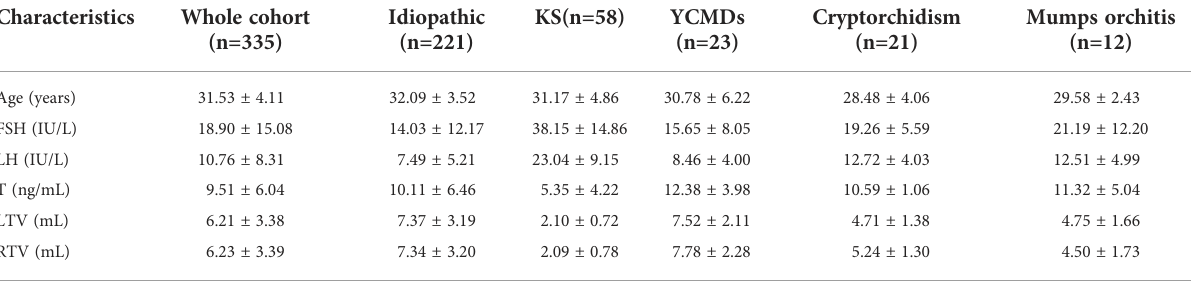
TABLE 1 Clinical characteristics of NOA patients with different etiologies.